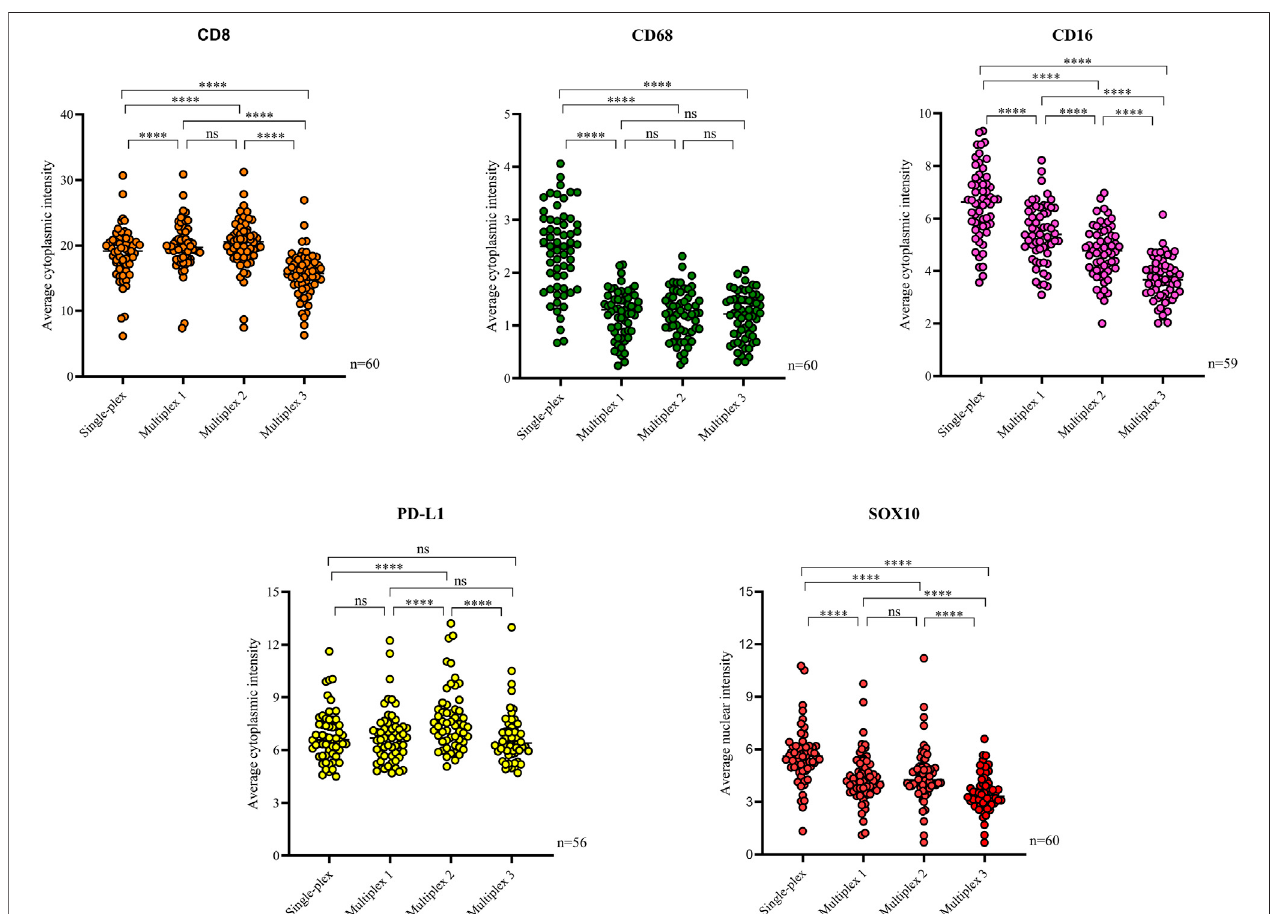
FIGURE 5 | Scatter plots comparing the average intensities of each marker in the single-plex immuno fl uorescence staining to the intensities in the three multiplex replicates. Single-plex immuno fl uorescence displayed higher marker intensities for CD68 ( n = 60), CD16 ( n = 59) and SOX10 ( n = 60) compared to the corresponding multiplex immuno fl uorescence staining. PD-L1 ( n = 56) single-plex and multiplex immuno fl uorescence staining demonstrated similar marker intensities. Single-plex immuno fl uorescence stainingwithCD68demonstrated alarger variationin marker intensities compared tothemultiplex immuno fl uorescence intensities. Multiplex 3 displayed lower cell intensities for markers CD8 ( n = 60), CD16, and SOX10. One-way ANOVA with Tukey ’ s HSD (honestly signi fi cant differences) test, **** = p < 0.0001, ns, non-signi fi